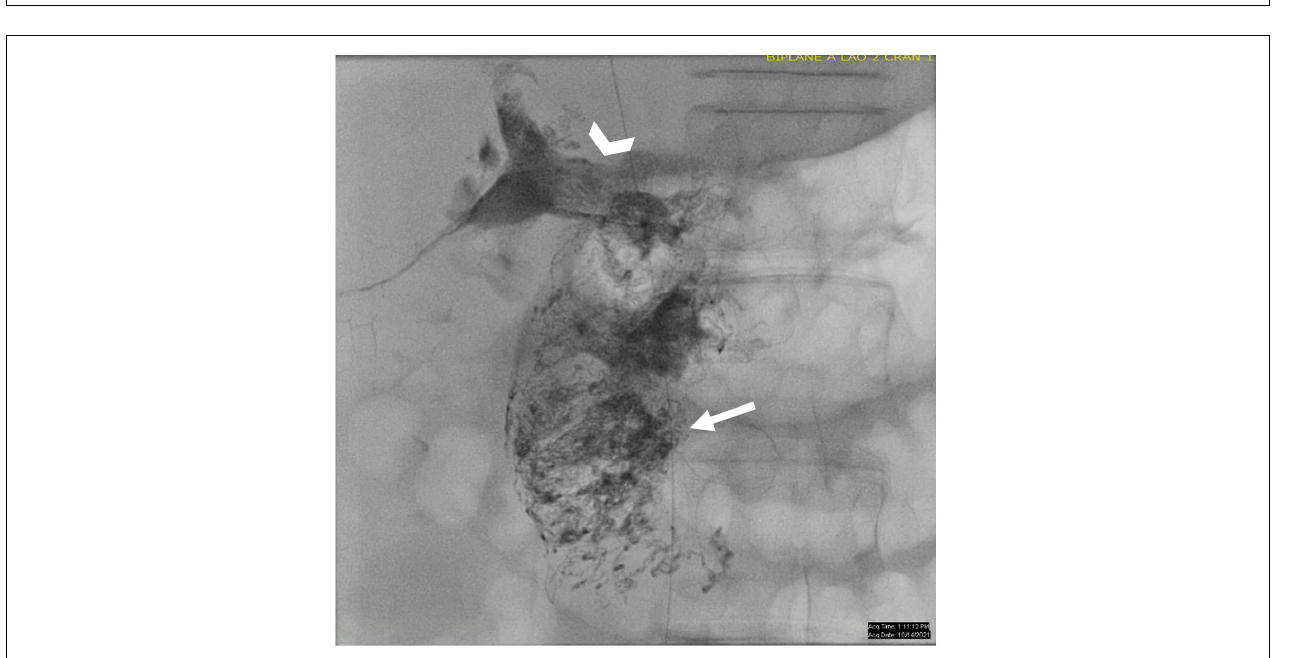
FIGURE 8 | Algorithm for PLE treatment (TD-thoracic duct, DCMRL-dynamic contrast lymphangiography, IN-intranodal, IH-intrahepatic, IM-intramesenteric, SQ-subcutaneous, OHT-orthotopic heart transplant).